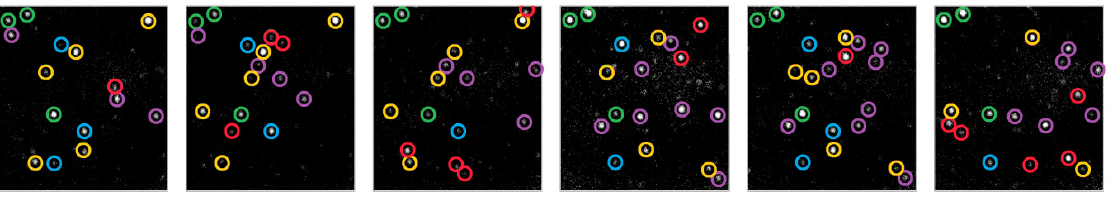
Figure 14. Sequence of wide-field images of one area of a sample containing 1 embedded in a pvac film recorded at 30 ° C. Size of the images 17×17 µm. Accumulation time of the image: 1